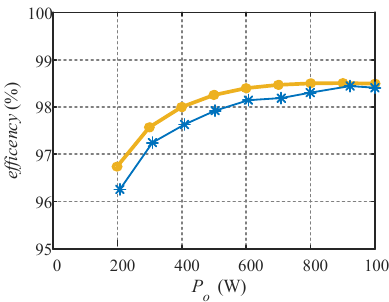
Figure 14. Efficiency curve of the closed ‐ loop control DCM inverter.